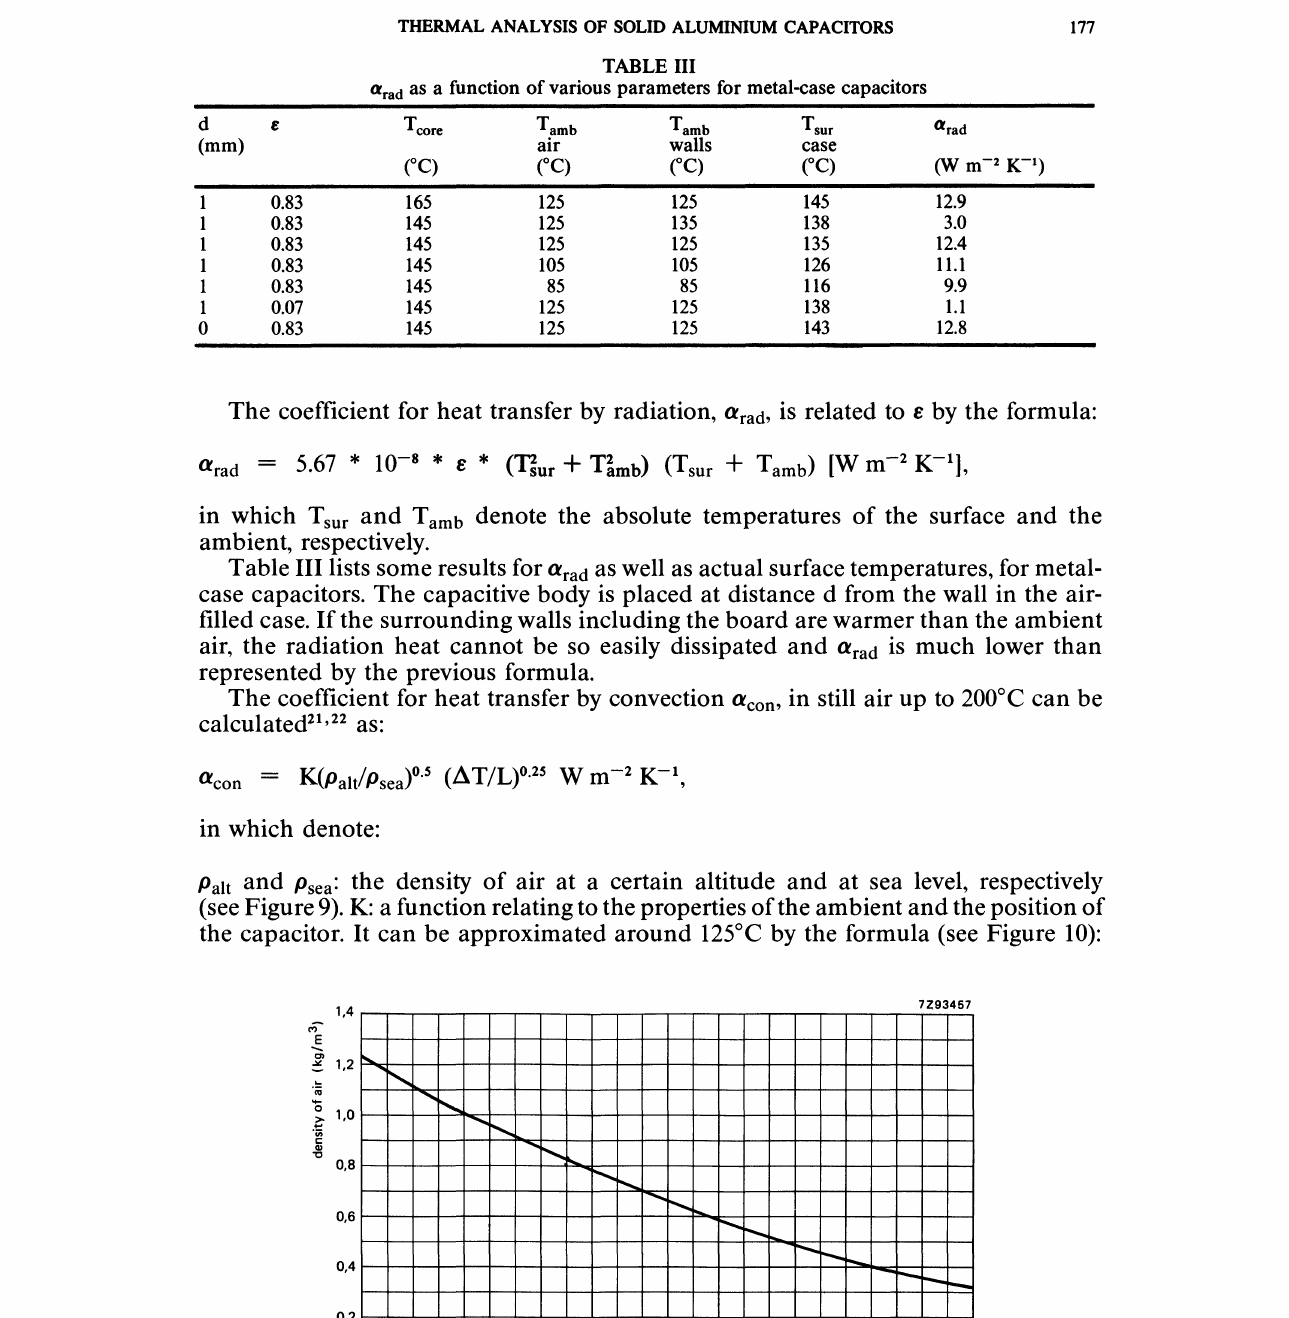
FIGURE 9 Density of air as a function of